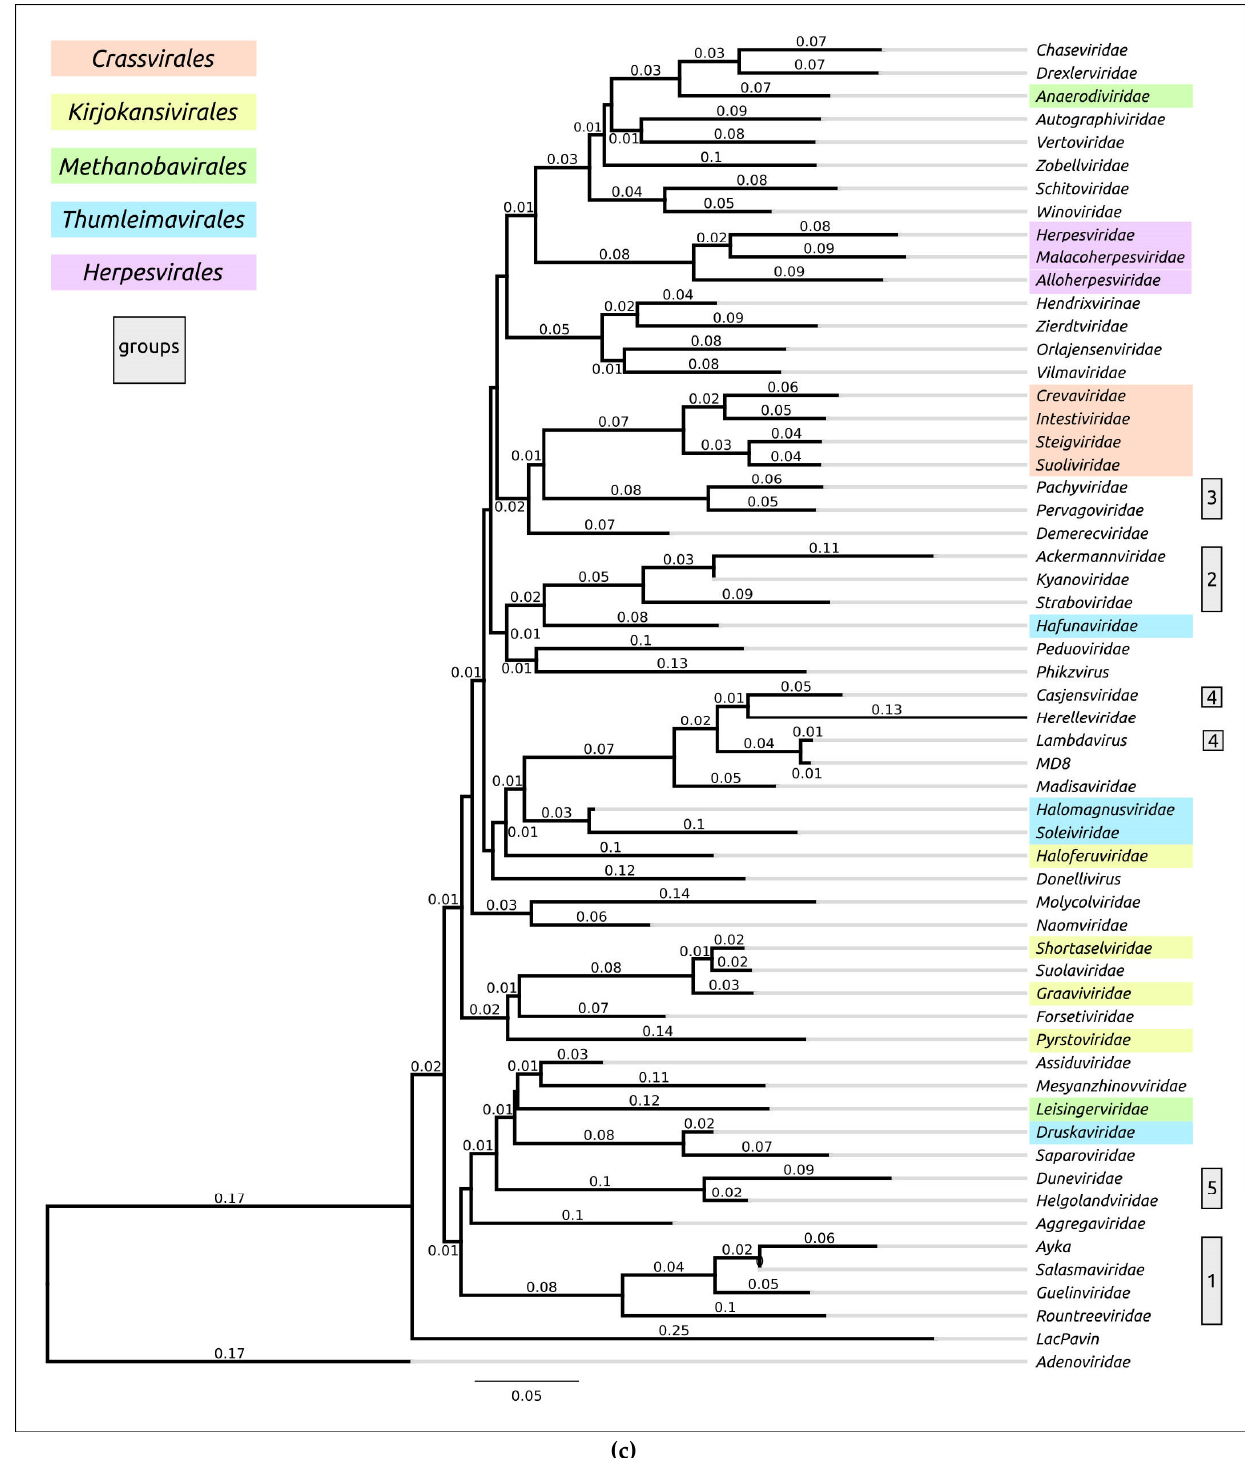
Figure A1. Dendrograms based on protein structure comparisons using mTM-align: ( a ) 57 major capsid protein and an encapsulin AF models. The tree was rooted to encapsulin; ( b ) 58 ATPase subunits of Heunggongvirae terminases and an Adenoviridae terminase. The tree was rooted to Ade- noviridae ; ( c ) 58 ATPase domains, extracted from AF models of ATPase subunits of Heunggongvirae terminases and an Adenoviridae terminase, and the tree was rooted to Adenoviridae . The branch lengths are measured with TM-scores.